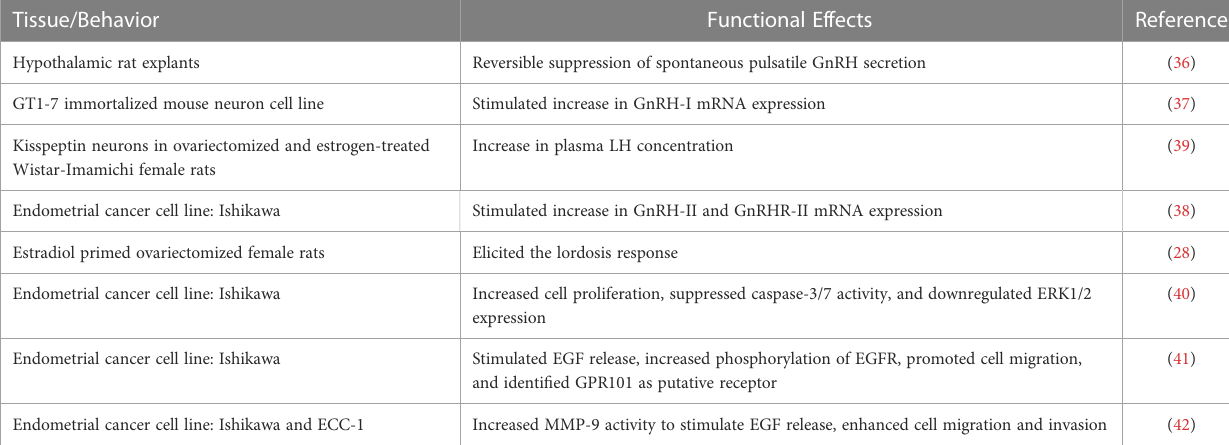
TABLE 1 Articles investigating GnRH-(1 – 5) biological activity in the brain and